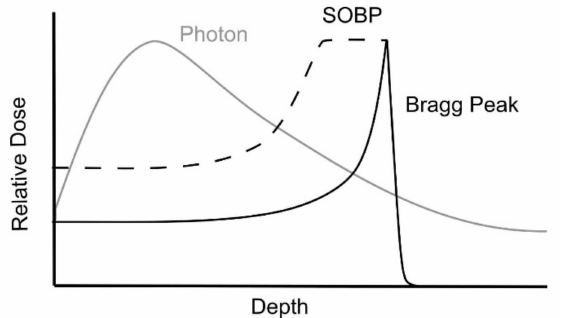
Figure 1. Depth-dose curves for photon and proton beams. Photons, with no mass and no charge, are highly penetrating, delivering dose throughout any volume of tissue. By contrast, heavy and charged proton particles deposit their energy mostly at the end of the particle path and, thus, deeper in the tissue. This phenomenon is reflected on the depth dose distribution, which has a typical peak (Bragg’s) followed by sharp dose fall-off. Modulated proton beams allow for spread-out Bragg peak (SOBP), covering the tumor target at various depths, at the cost of an increased entrance